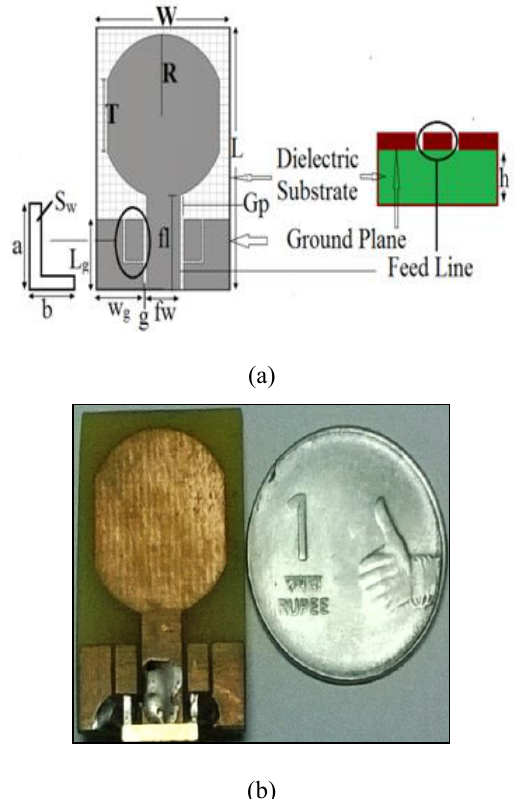
Figure 1: Geometrical model and prototype of CPW fed UWB antenna with its parameters Table 1: Optimized dimensions of proposed antenna Dimension of proposed Antenna